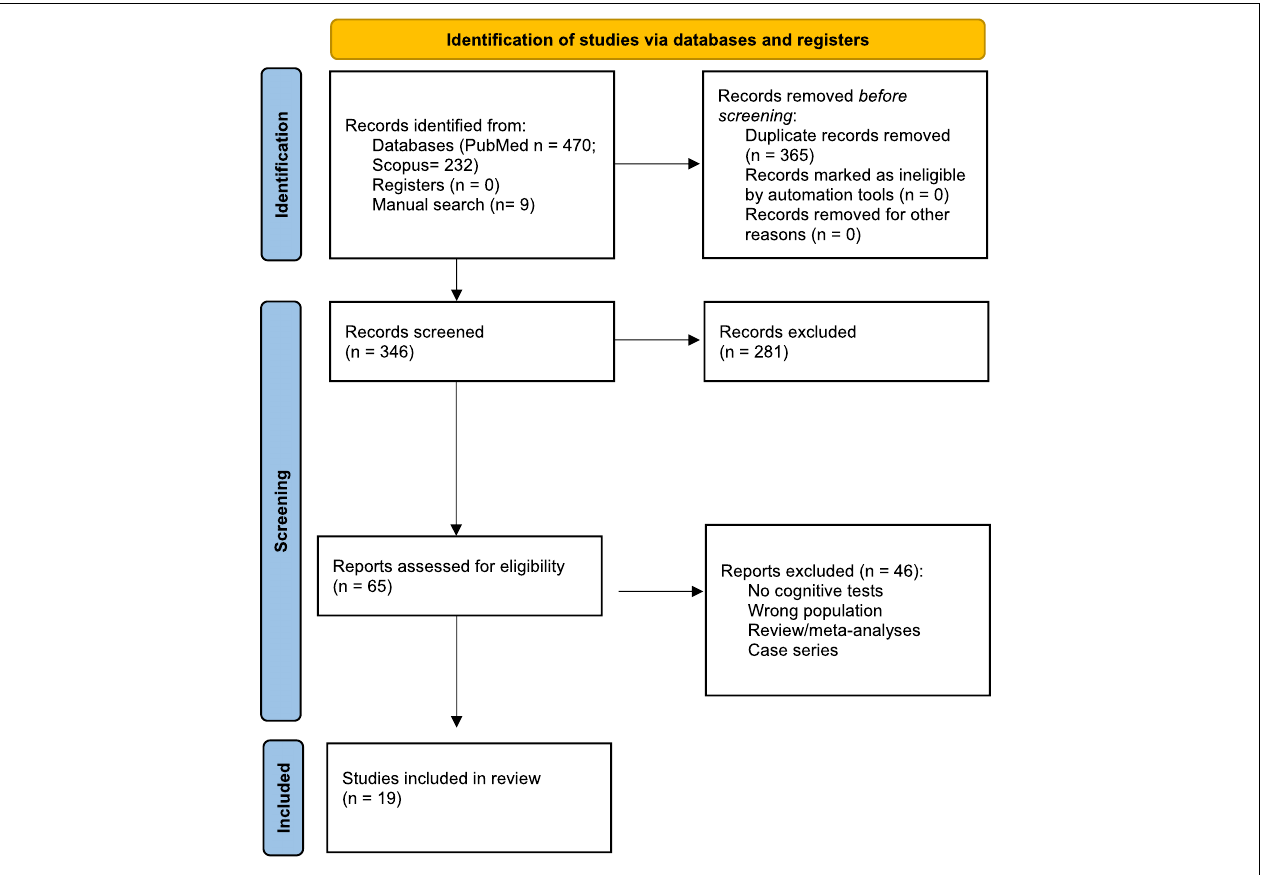
FIGURE 1 | PRISMA 2020 flow diagram for the systematic review, which included searches of Pubmed and Scopus databases.